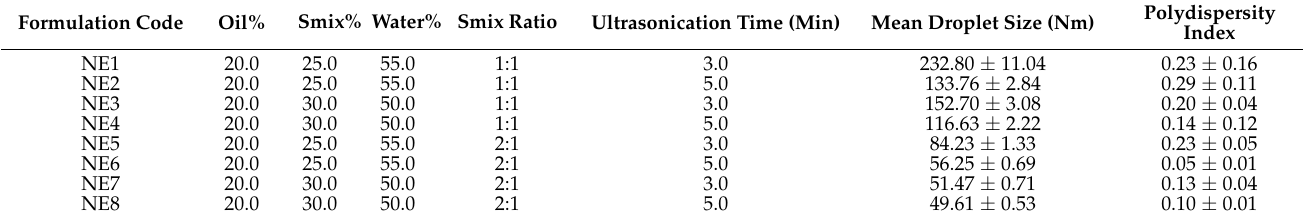
Table 1. Formulation composition of curcumin loaded NE system prepared through ultrasonication technique. Formulation Code